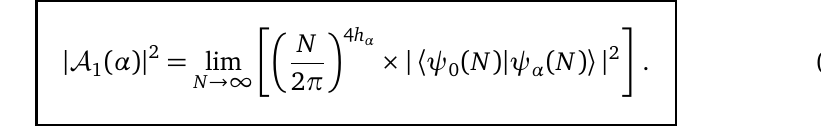
Figure 2: Inserting v − α ( 0,0 ) v α ( − M ,0 ) amounts to twisting the periodic boundary conditions on the middle part of the cylinder. Within the transfer matrix formalism, the state at the edge of the leftmost cylinder is the untwisted ground state | ψ and likewise at the edge of the rightmost cylinder. Upon sending M → ∞ , the states at the edge of the middle cylinder are projected to the twisted ground state | ψ α ( N ) 〉